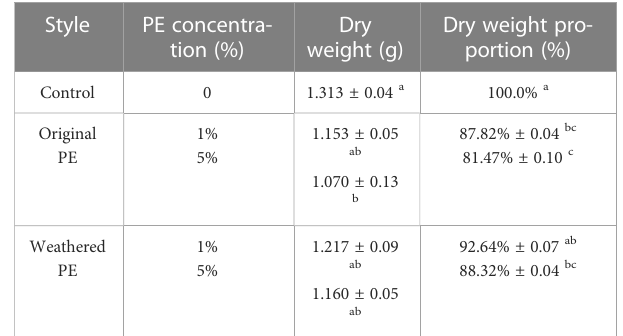
TABLE 1 Biomass of original or weathered PE treated sweet potato planting in Cd contaminated soil.